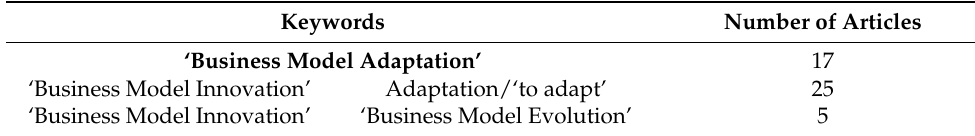
Table 1. Keywords included in the article’s